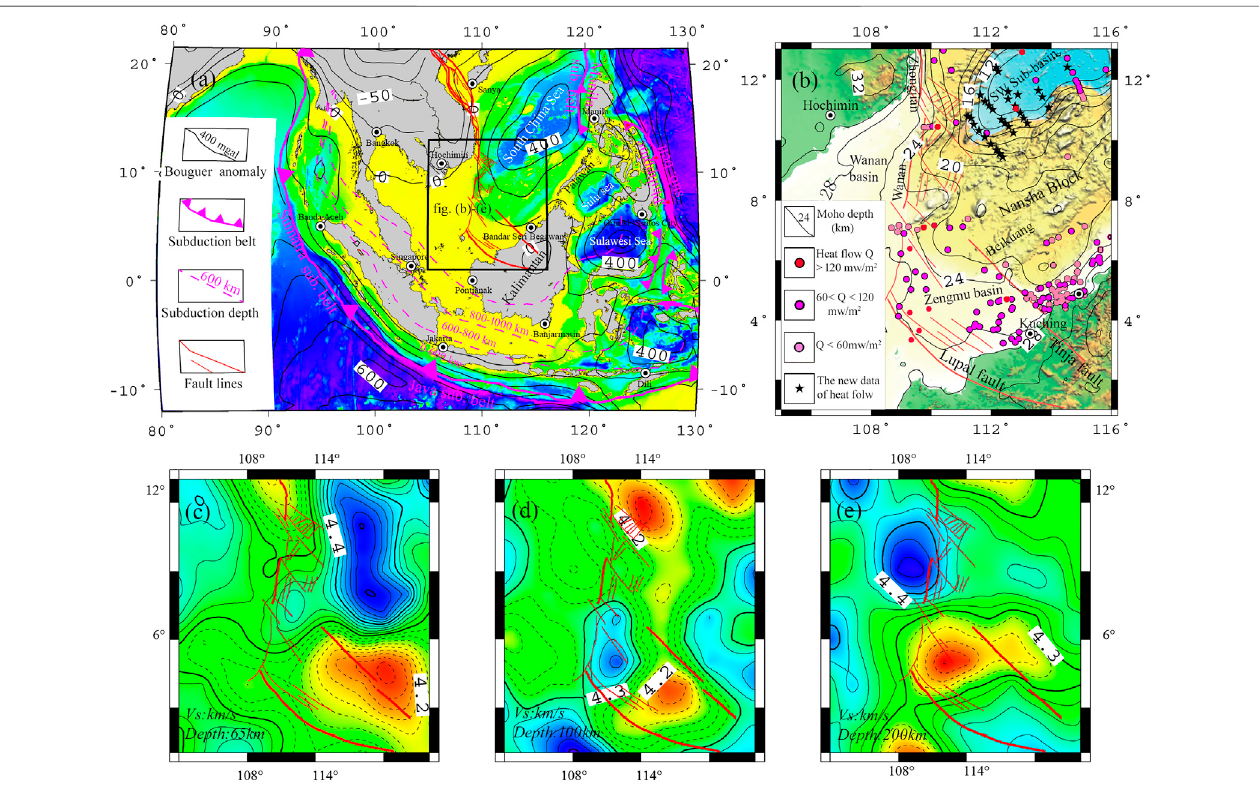
FIGURE1| Regionalmap ofthesouthwestern margin ofSouthChinaSea(SCS). (A) Tectonicmap ofthesouthwesternmargin ofSCS. (B) Map ofthegeothermal geology in the study area. (C – E) V s map at depths of 65, 100, and 200 km (Chen et al., 2021).